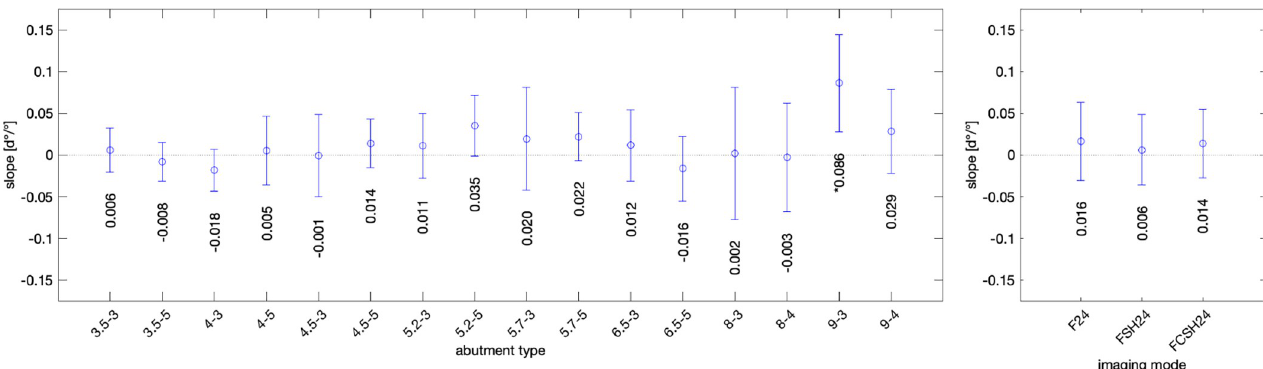
Fig 8. Abutment angle measurement dependence on the scanning angle. Left graph: Summary statistics for data in S3 Fig. Mean slope across 3 imaging modes (F24, FSH24, FCSH24) is depicted in units of error in abutment angle measurement (d˚) divided by image angle in units of degree (˚), i.e., d˚/˚. Error bars present the confidence interval across F24, FSH24, FCSH24. Data is shown for all 16 abutment types listed in S1 Table. Right graph: Mean slope and standard deviation across 16 abutment types for each imaging mode (F24, FSH24, and FCSH24). The slope is negligible, suggesting the error is independent of the tested scanning angle.